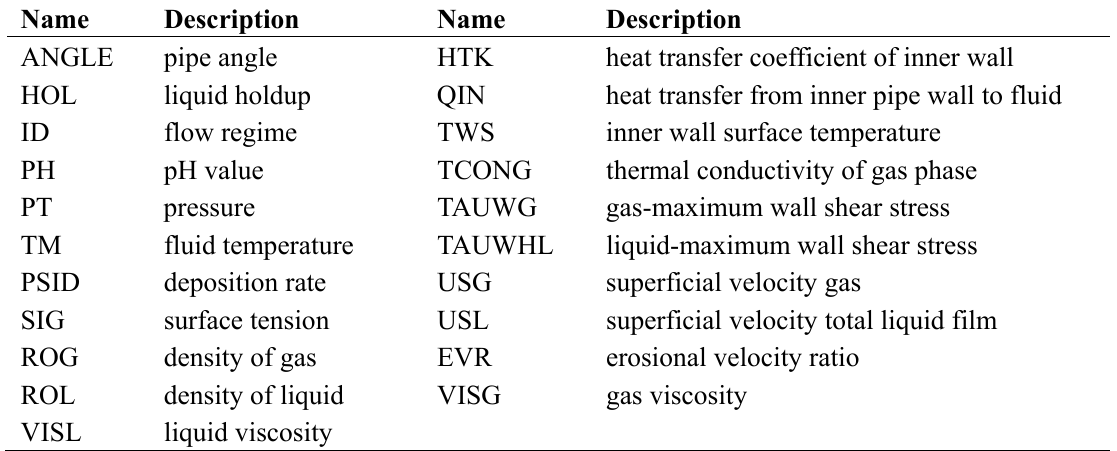
Table 8. The calculated internal corrosion influence factors of the